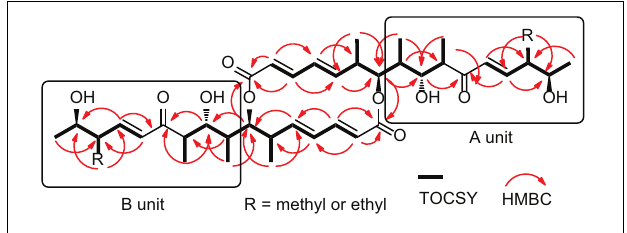
FIGURE 2 | Key TOCSY and HMBC correlations of 1 and 2